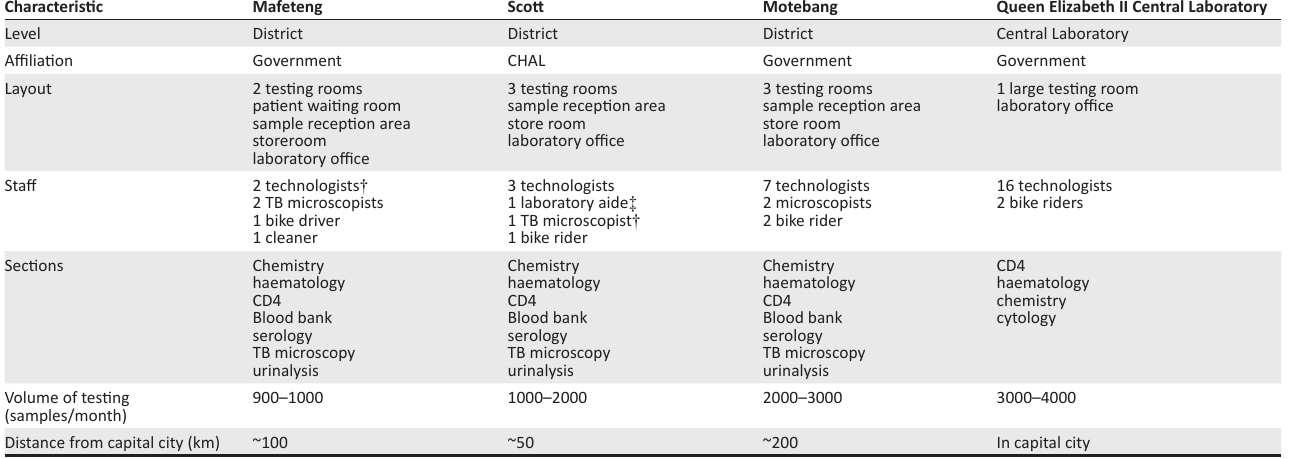
TABLE 1: Profiles of the four laboratories where the mentorship model was implemented.